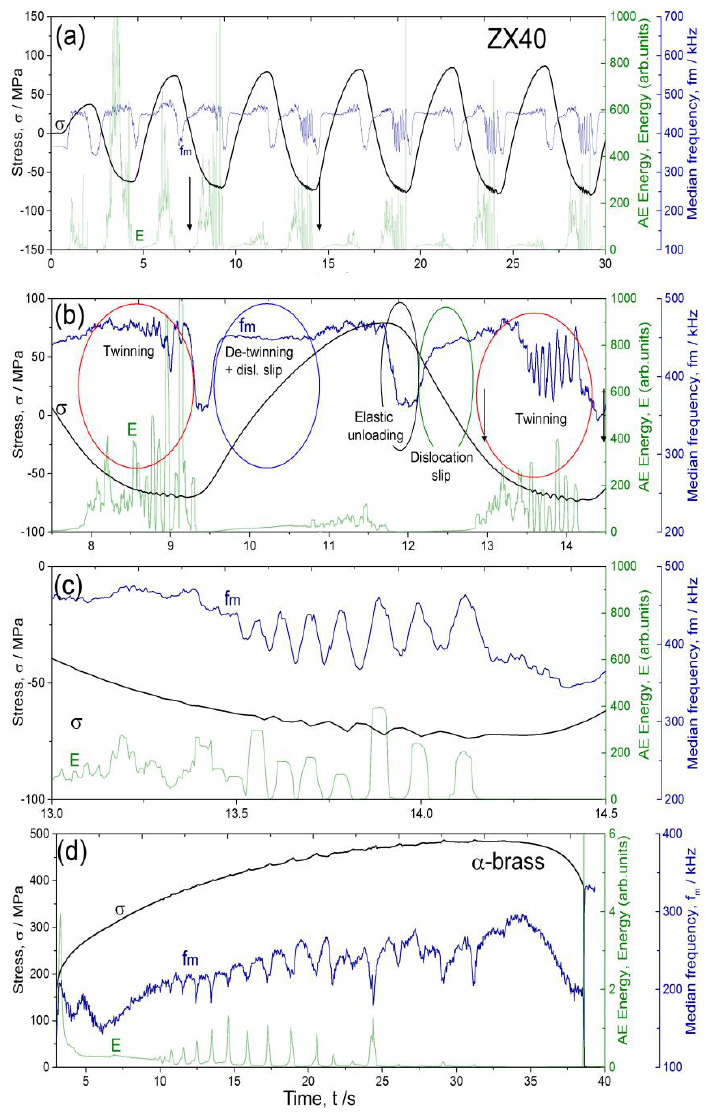
Figure 5. Acoustic emission energy E and median frequency f m plotted as a function of time during early rapid hardening stage of the ZX40 alloy (Mg-4Zn-0.56Ca tested at Δε t /2 = 1 × 10 −2 ). ( a – c ); ( b ) shows an enlarged fragment of data indicated on ( a ) by arrows; ( c ) shows an enlarged fragment of data indicated on ( b ); the dominating deformation mechanisms highlighted on ( b ) are identified through the cluster analysis of the AE time series; ( d ) shows the typical AE diagram obtained during monotonic deformation of α-brass exhibiting the Portevin-Le Chatelier effect due to collective dislocation motion: cf. the difference in the f m behavior visible in ( c , d ) [57]. The behavior of the median frequency, which is shown in Figures 4 and 5, is similar for both specimens and is specific for deformation mechanisms operative in Mg. The details of the particular features of the f m evolution in response to dislocation slip and twinning have been highlighted in [32] (cf. also [54,56]). One can notice that after the start of the test the AE spectral density shifts to a high frequency domain and the f m value increases sharply as is usually observed due to dislocation production and accumulation in fcc and bcc metals and alloys [56]. The f m value drops at the point of reversal of the loading direction, and then it starts rising again as deformation proceeds beyond a certain stress, which can be associated with a “true” yield stress and which reasonably increases as